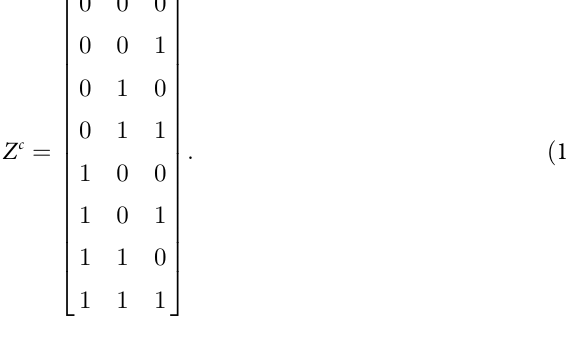
Table 1. List of parameters used in the